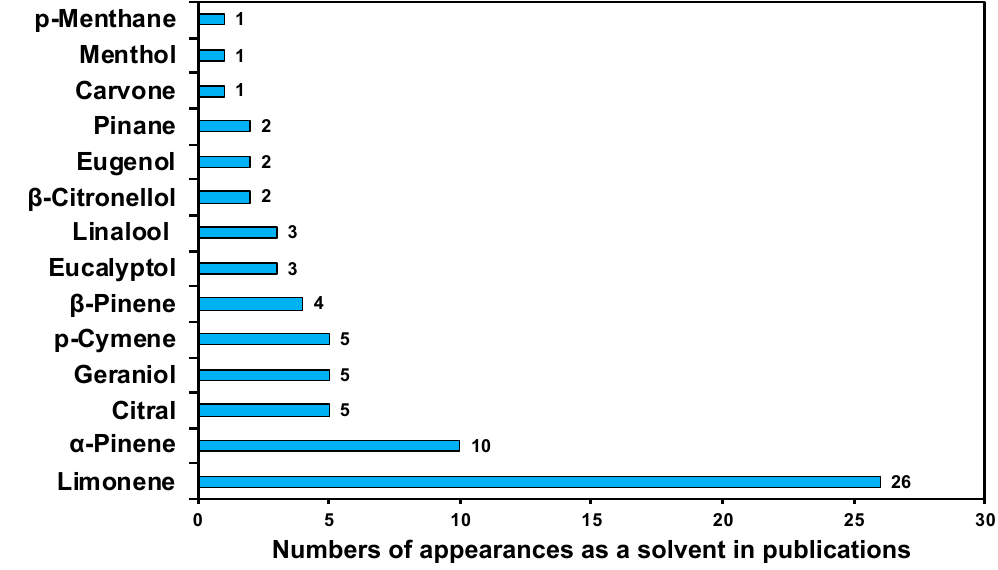
Figure 6. Numbers of appearances in the published papers of terpenes and terpenoids as solvents.